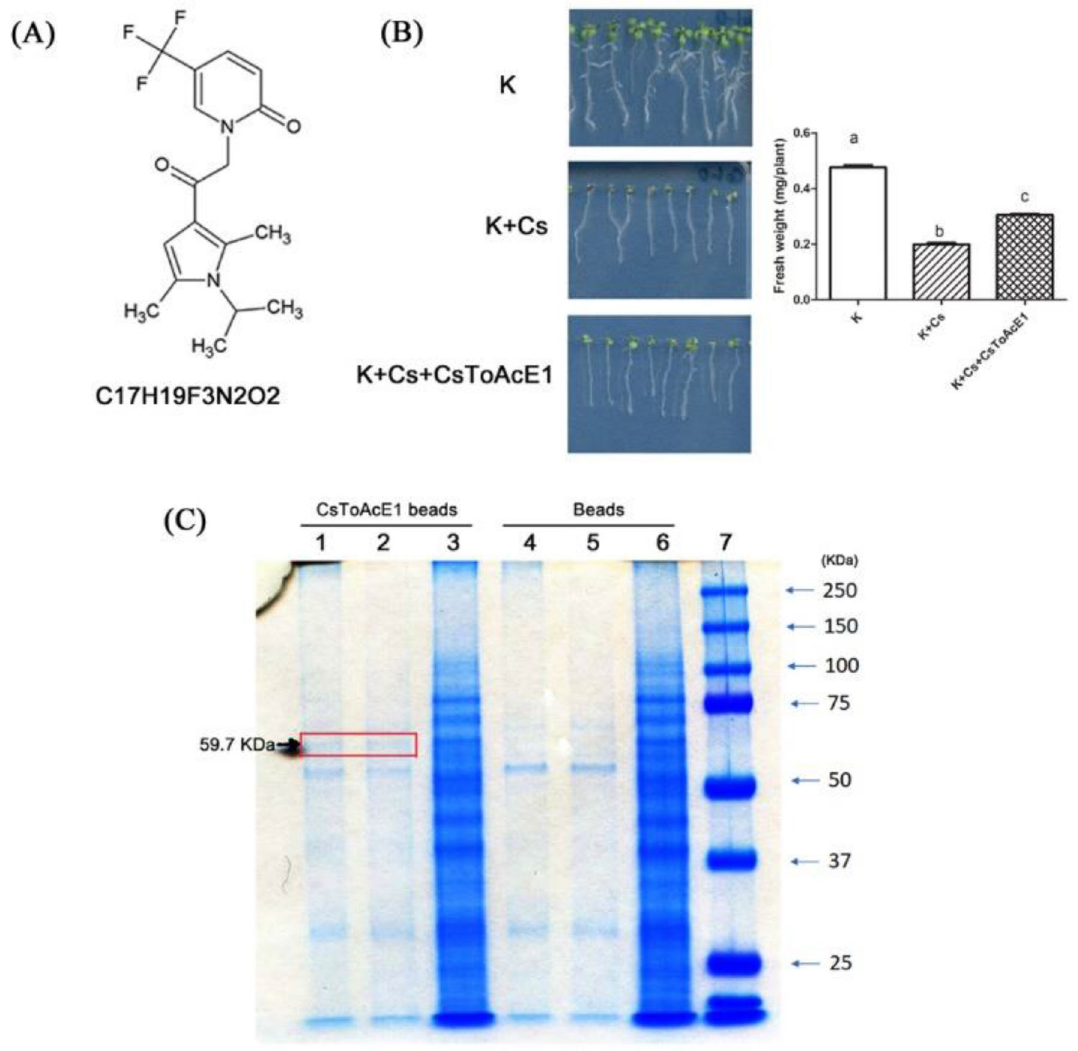
Figure 1. Identification of a CsToAcE1-binding protein in Arabidopsis . ( A ) Chemical structure of CsToAcE1 (1-[2-[2,5-Dimethyl-1-(propan-2-yl)-1 H -pyrrol-3-yl]-2-oxoethyl]-5-(trifluoromethyl)-1,2-dihydropyridin-2- one). ( B ) Phenotype of Arabidopsis plants under the condition of sufficient K and Cs stress (0.5 mM K, 0.3 mM Cs), with or without supplementation of the growth medium with 25 µM of CsToAcE1. The fresh weight of seedlings were measured (n > 60). Different letters indicate significant differences ( p < 0.05) between treatments determined by a one-way ANOVA followed by a Bonferroni’s multiple comparisons test. ( C ) Coomassie blue stained SDS-PAGE gel of proteins eluted from CsToAcE1-PALC agarose beads. Total protein extracts of 11-day- old Arabidopsis plants were incubated with either CsToAcE1-PALC agarose beads (CsToAcE1 beads) or control beads without the chemical (Beads). Bound proteins were eluted from the beads at 25 °C (lane 1, 4) or at 100 °C (lane 2, 5). Inputs (lane 3, 6). Size marker (lane 7). The bands present in lanes 1 and 2 and not in lanes 4 and 5 (red box) were excised and subjected to sequence